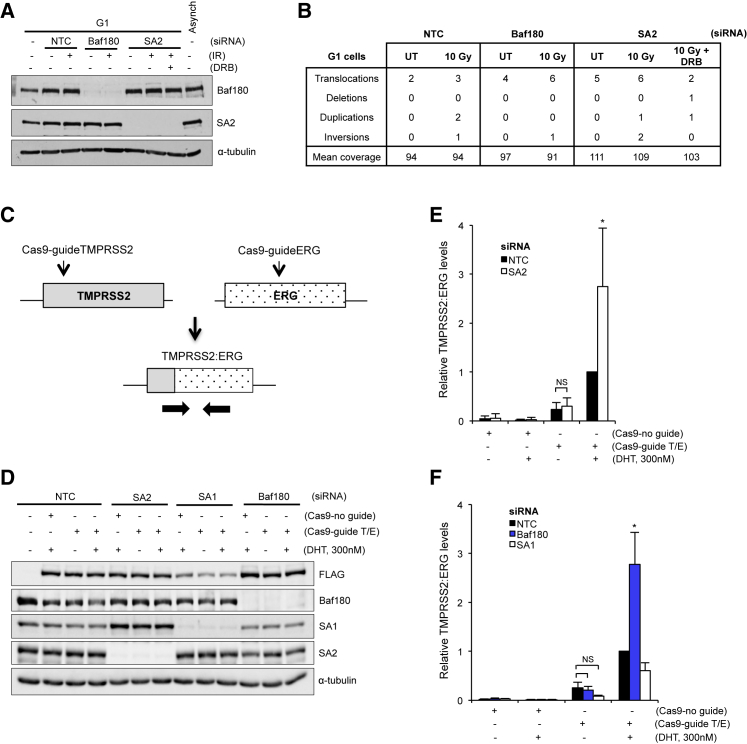
PBAF and Cohesin Are Important for Preventing Chromosome Rearrangements at DSBs in G1, Specifically at DSBs near Strong Transcriptional Activity(A) Western blot analysis of cell extracts prepared from G1-arrested U2OS cells. Cells were depleted of the indicated factors (NTC, non-targeting control) and harvested 6 hr after irradiation with 0 or 10 Gy. DRB was used for 1 hr prior to irradiation in the SA2-depleted cells to inhibit transcription. α-Tubulin was used as a loading control.(B) Table of large-scale genome rearrangements identified in BAF180- or SA2-depleted G1 phase cells treated as in (A) using differential exome sequencing. UT, untreated. DRB was used for 1 hr prior to irradiation in the SA2-depleted cells to inhibit transcription.(C) Schematic illustrating the CRISPR-Cas9 system for generating DNA DSBs in the TMPRSS2 and ERG genes. Guide RNA positions are indicated (Cas9-guideTMPRSS2 and Cas9-guideERG). Translocation between these genes is monitored by qRT-PCR using a forward primer that flanks the fusion and a reverse primer that recognizes the ERG gene.(D) Western blot analysis of whole-cell extracts prepared from LNCaP cells transfected with the indicated siRNAs and FLAG-tagged Cas9 with or without the TMPRSS2 and ERG guide RNAs (Cas9-guideT/E or Cas9-no guide) in the presence or absence of 300 nM DHT.(E and F) Relative TMPRSS2:ERG translocation frequency monitored by qRT-PCR as outlined in (C) in cells treated as in (D). Cells were treated with siRNA targeting SA2 (E), or BAF180 or SA1 (F). NTC, non-targeting control. Data are presented as the mean ± SD; n = 6 (E) n = 3 (F) biological repeats. ∗p < 0.05, ∗∗p < 0.01 using unpaired Student’s t test. NS, not significant.See also Figure S6.